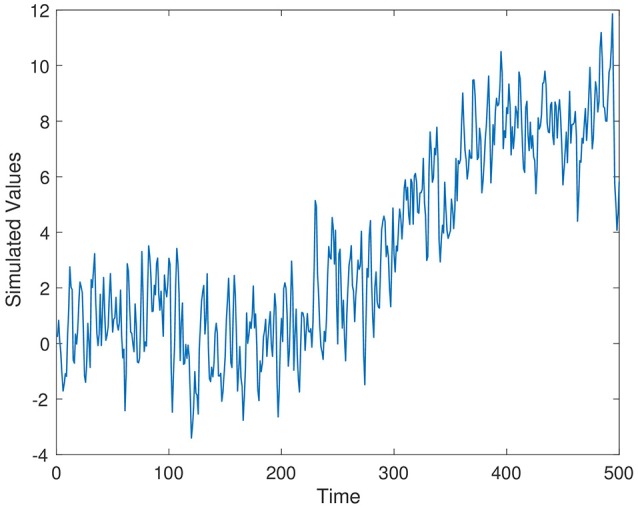
Simulation time series 3, ρ3 = 0.5.